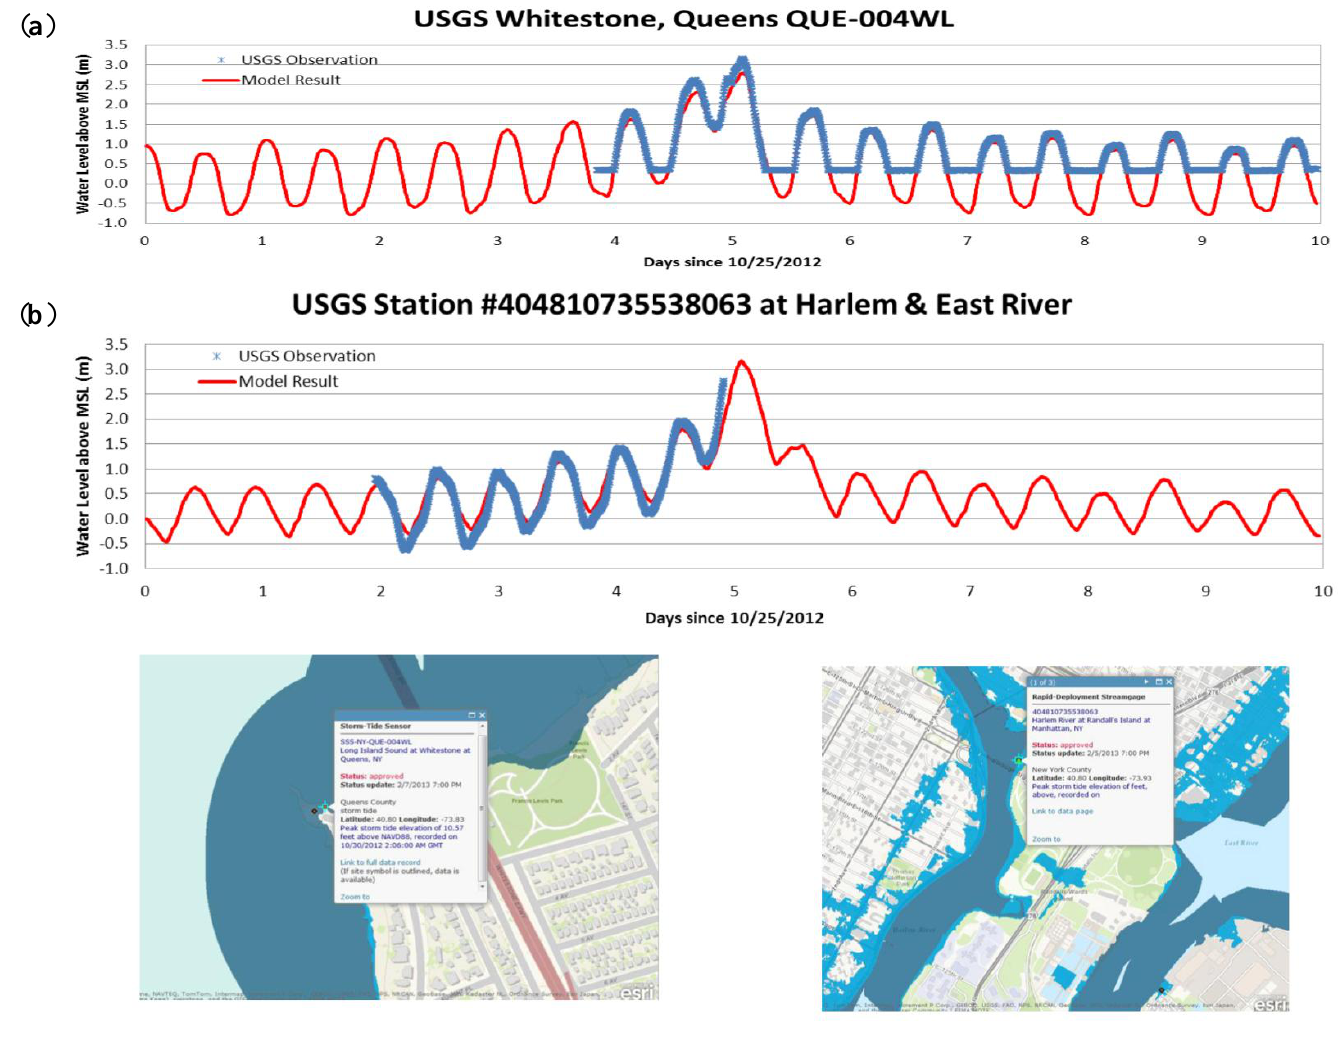
Figure 5. ( a ) Simulated storm tide time series (red) versus measured time series by rapid deployed gauged (blue) in Whitestone, Queens, and ( b ) at the confluence of the Harlem and East